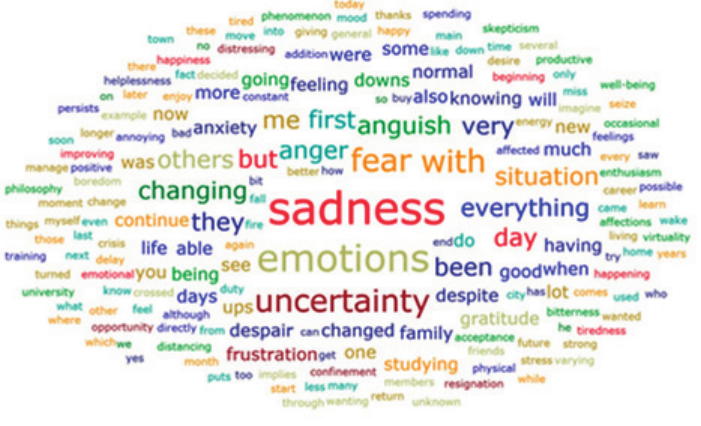
Figure 1. Emotions in times of COVID-19 pandemic. Tag cloud by Atlas.ti 8 (source: created by